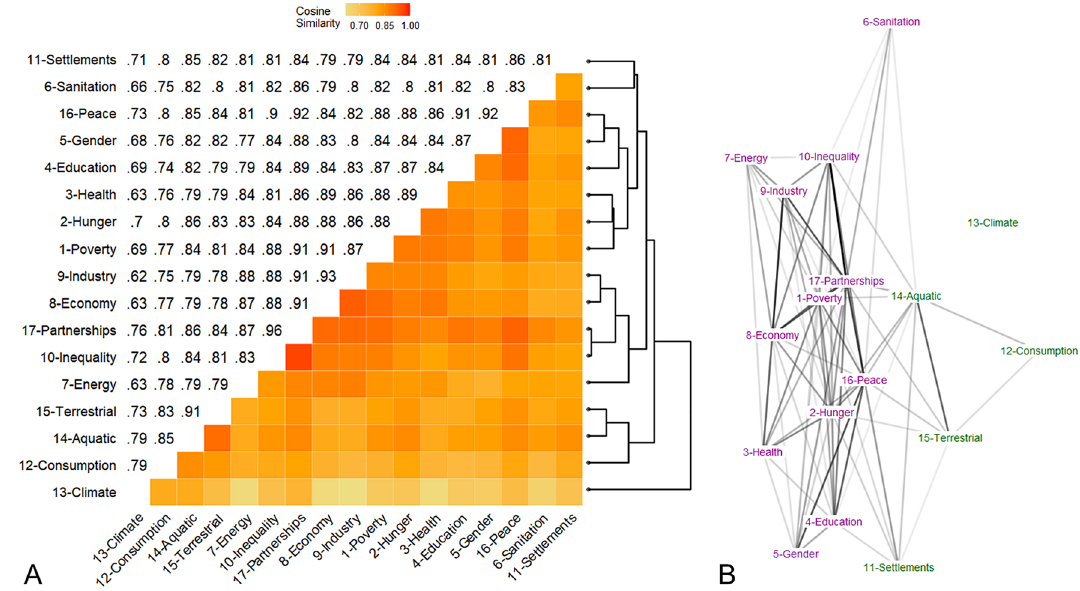
Figure 1. Discursive overlap between SDGs based on cosine similarity in doc2vec embeddings. (A) Heatmap of cosine similarity matrix with dendrogram of matrix hierarchical clustering. (B) Weighted network of cosine similarities (node colors represent subgroups identified via the Louvain network community detection algorithm 40